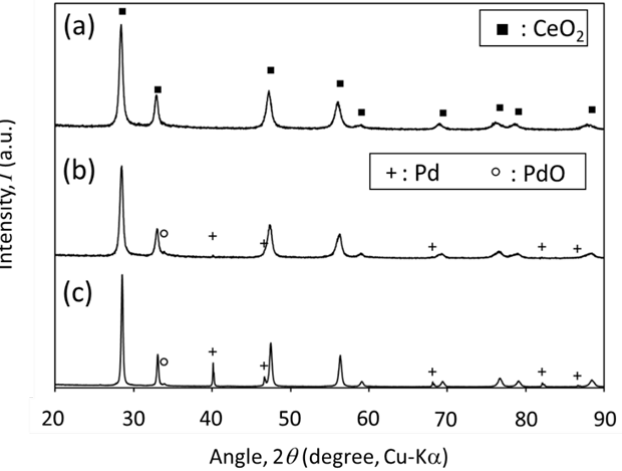
Figure 4. XRD patterns of PdCe4 after heating at ( a ) 800 °C, ( b ) 850 °C, and ( c ) 900 °C for 2 h in air.